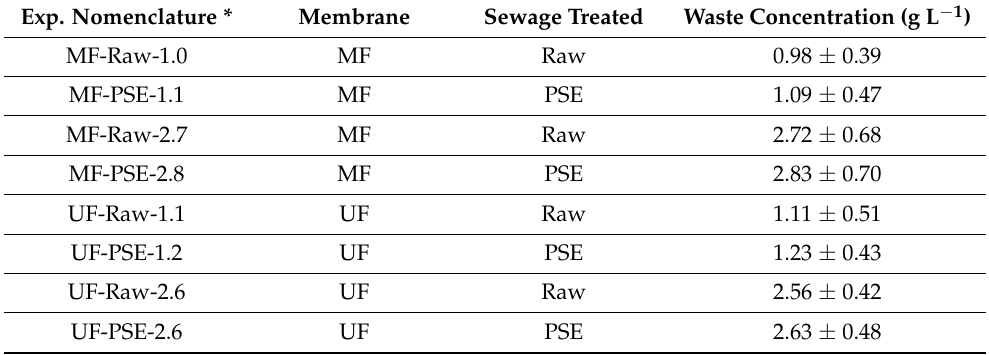
Table 2. Experimental